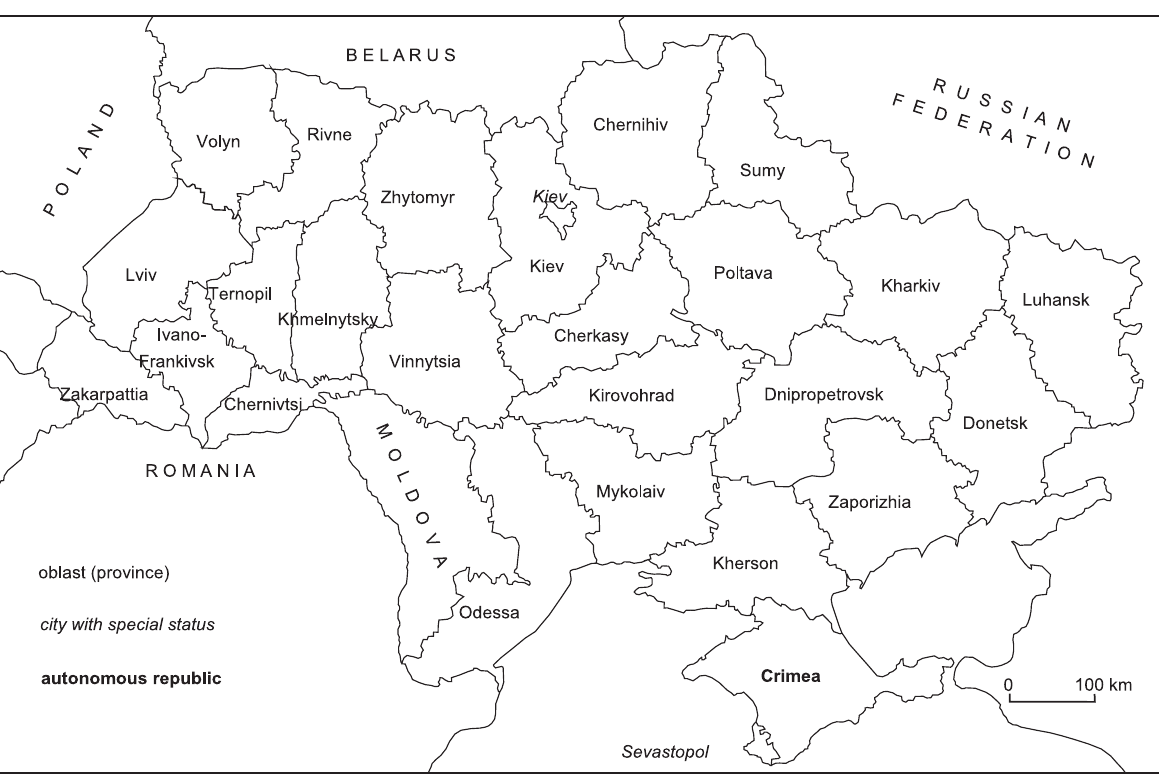
Fig. 1. Administrative division of Ukraine Source: Kučabs´kij (2010: